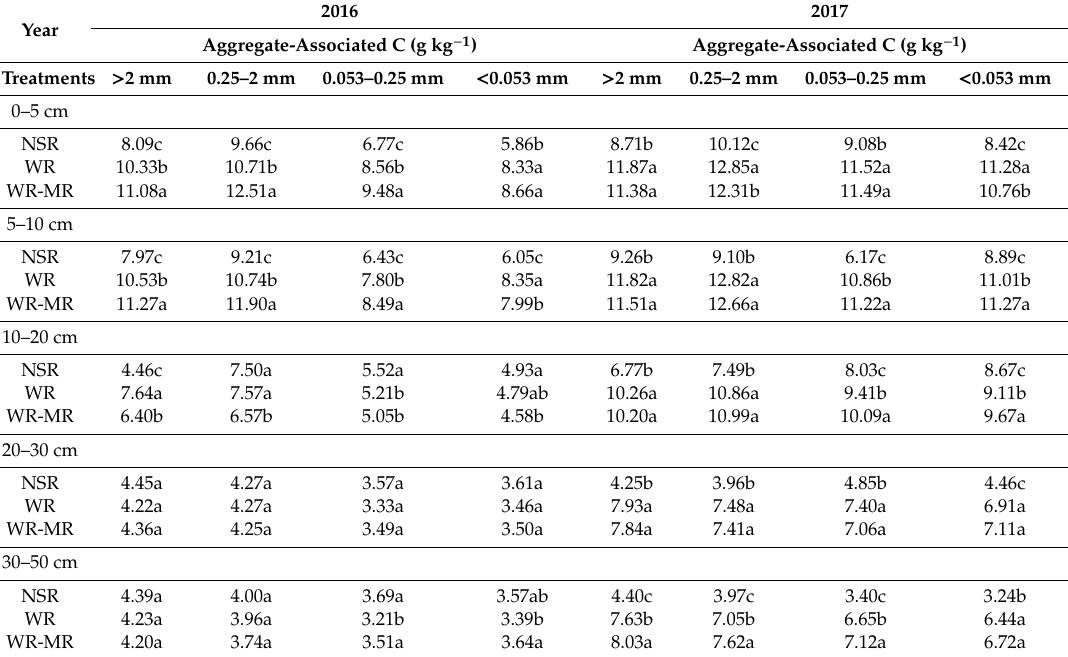
Table 4. E ff ects of straw return modes on aggregate-associated C